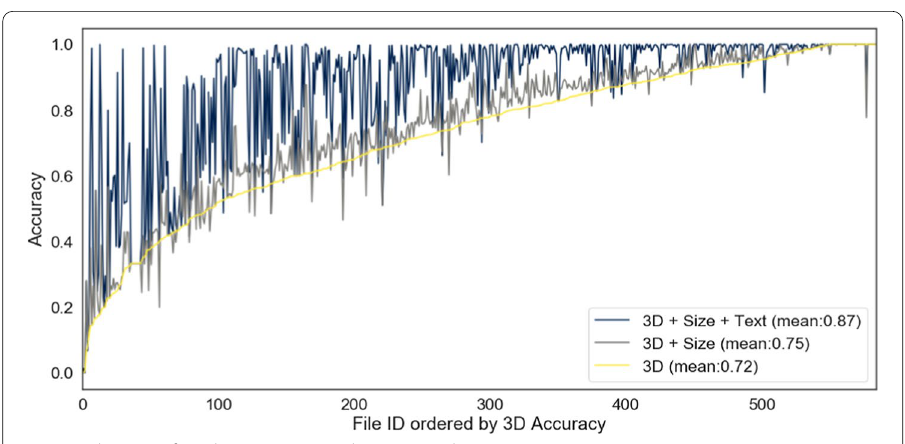
Fig. 12 Changes of prediction accuracy changes per data